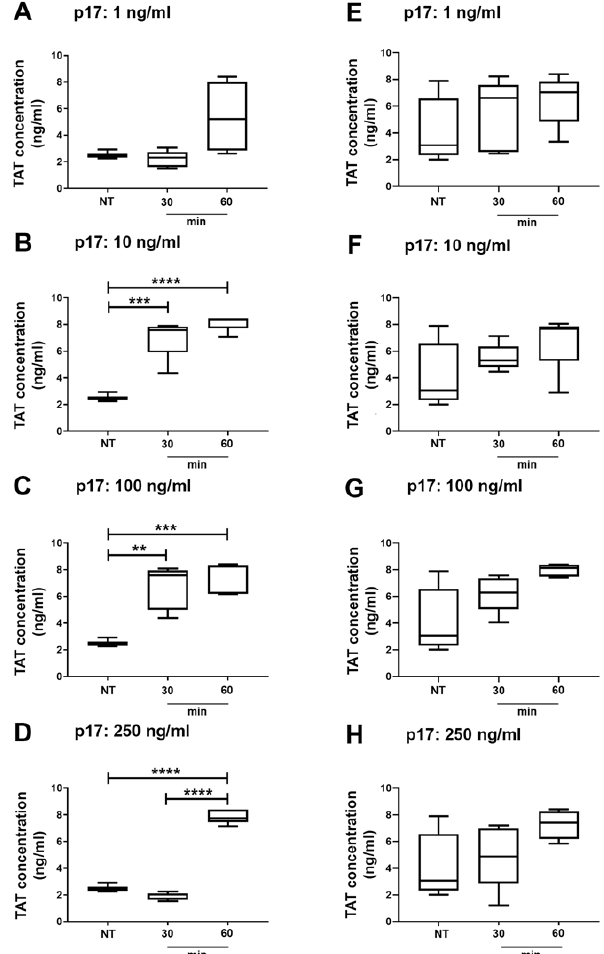
Figure 7. Increased TAT complex formation is observed in plasma from wild type but not autophagy-deficient mice treated with p17. C57BL / 6 ( A – D ) and BECN-1 ( E – H ) mice were i.v. injected or not (NT, not treated mice) with 1 ng / mL ( A , E ), 10 ng / mL ( B , F ), 100 ng / mL ( C , G ) and 250 ng / mL ( D , H ) of p17, respectively. Blood samples were collected at 30 and 60 min following p17 injection and further analyzed for TAT complex formation by ELISA. Results are expressed as TAT concentration in plasma of mice. Statistical analysis was performed by one-way ANOVA with Tukey’s multiple comparison test (** p < 0.01, *** p < 0.001, **** p < 0.0001). In box and whiskers graphs, boxes extend from the 25th to the 75th percentiles, lines indicate the median values, and whiskers indicate the range of values. Each box represents the mean ± SEM of five